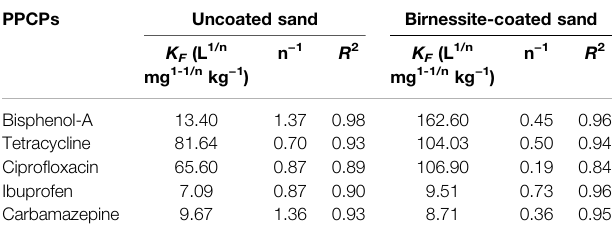
TABLE 2 | Freundlich adsorption isotherm model parameters for the PPCPs.